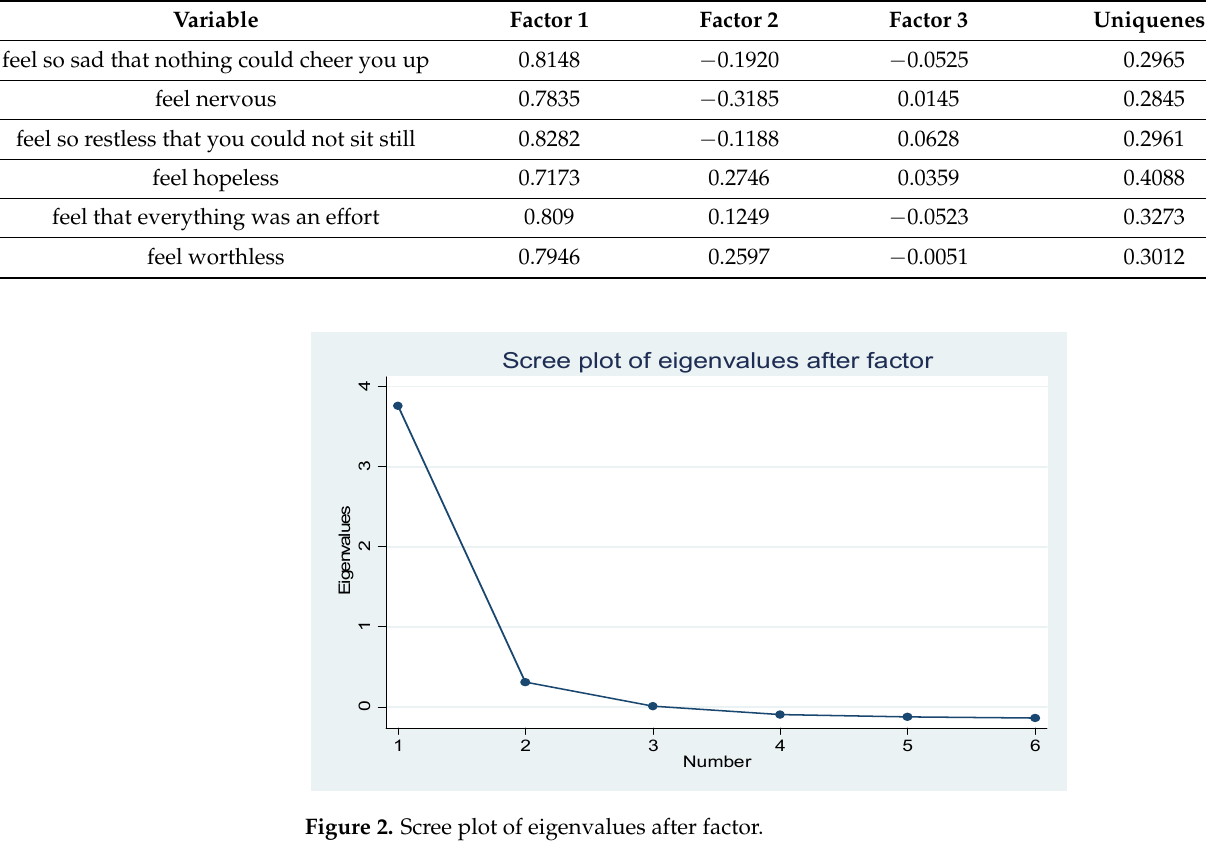
Table 4. Exploratory factor analysis of distress.